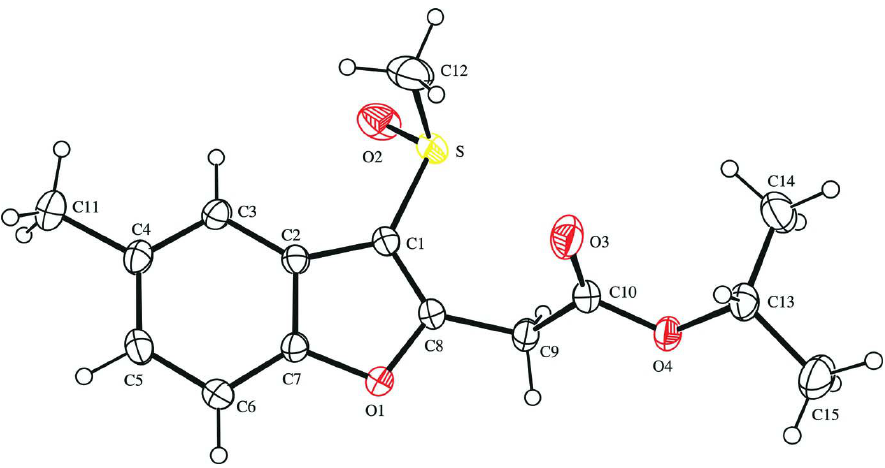
Figure 1 The molecular structure of the title compound, showing the displacement ellipsoids drawn at the 30% probability